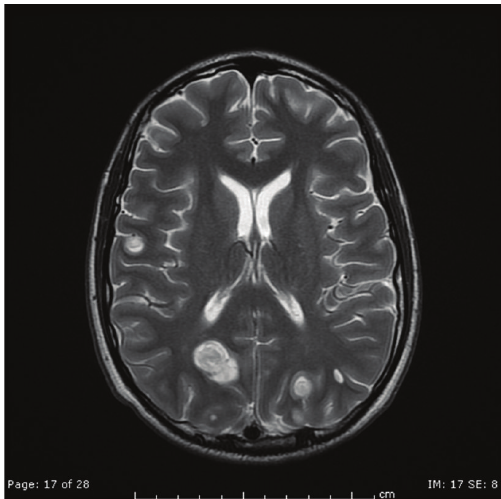
Figure 2: Multiple ring-enhancing and punctate areas of abnormal enhancement in the cerebral hemispheres